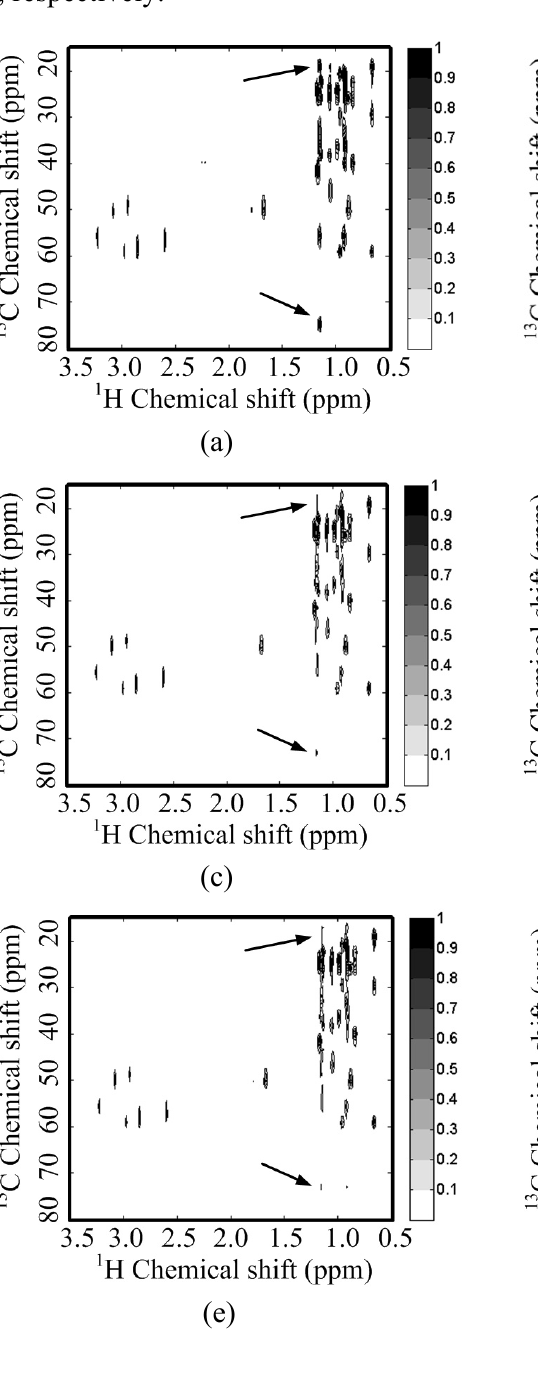
= 128 points) and 1 norm, respectively; ( e , f ) spectra 1 norm, respectively; 1 0.5